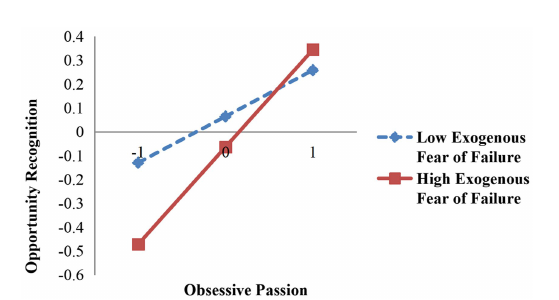
FIGURE 3 Moderating effect of exogenous fear of failure between obsessive passion and entrepreneurial